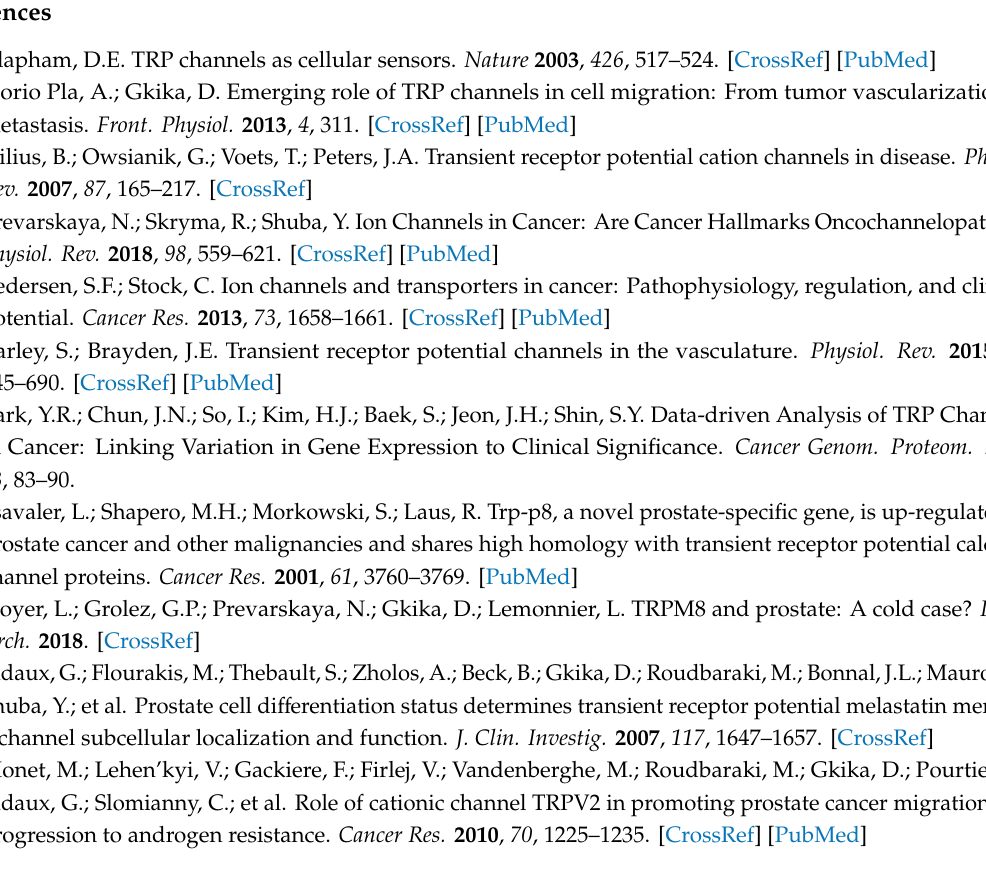
Figure S1: Assessment of external and internal controls of real-time qPCR used for the normalization of expression data, Figure S2: Representative immunoblots blots showing TRPA1 ( n = 3), TRPV2 ( n = 5), TRPC3 ( n = 3), and TRPC6 (n = 3) expression in HPrMEC and PTEC1, 2 and 3, Figure S3: Validation of ‘prostate-associated’ channel overexpression in HMECs for their functional characterization in ECs, Figure S4: hTERT PTEC characterization, Figure S5: Validation of ‘ prostate-associated ’ channel in tubulogenesis in vitro; Figure S6: Whole scans of the immunoblots used in Figures 4 and S2, Figure S7: Whole scans of the immunoblots used in Figures 3, 5, S3 and